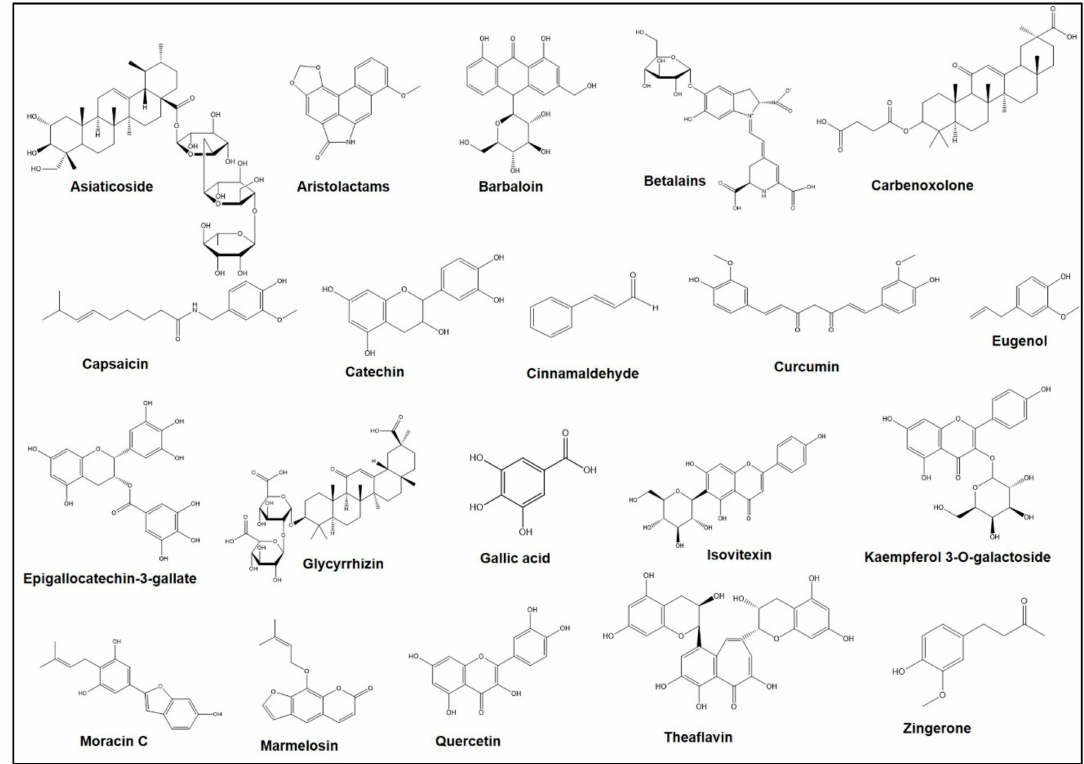
Figure 1. Chemical structures of different bioactive compounds derived from the medicinal